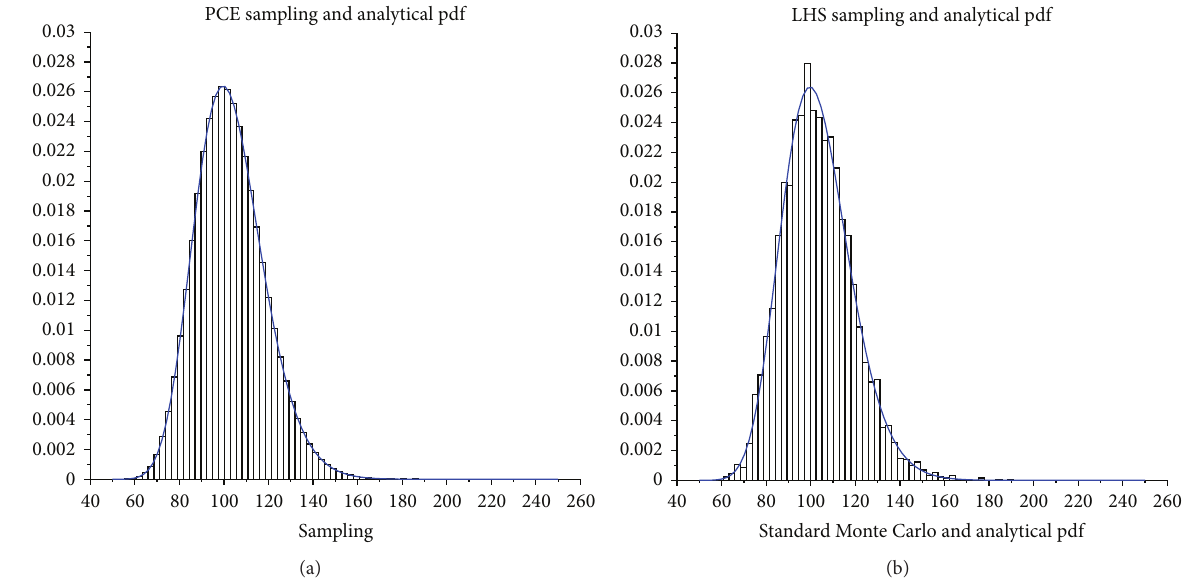
Figure 7: Probability density function of GBM at time 𝑇 = 1 , whose parameters are 𝑟 = 3 %, 𝜎 = 15 %, and starting value 𝑆 0 = 100 (blue curve) and histogram of a sampling (size = 5000 ) of the 𝑆 (𝑝) 𝑇 for 𝑝 = 15 (a). (b) displays the analytical probability density function of GBM, for the same parameters values and a standard Monte Carlo sampling of size 5000 of the GBM-analytical solution.